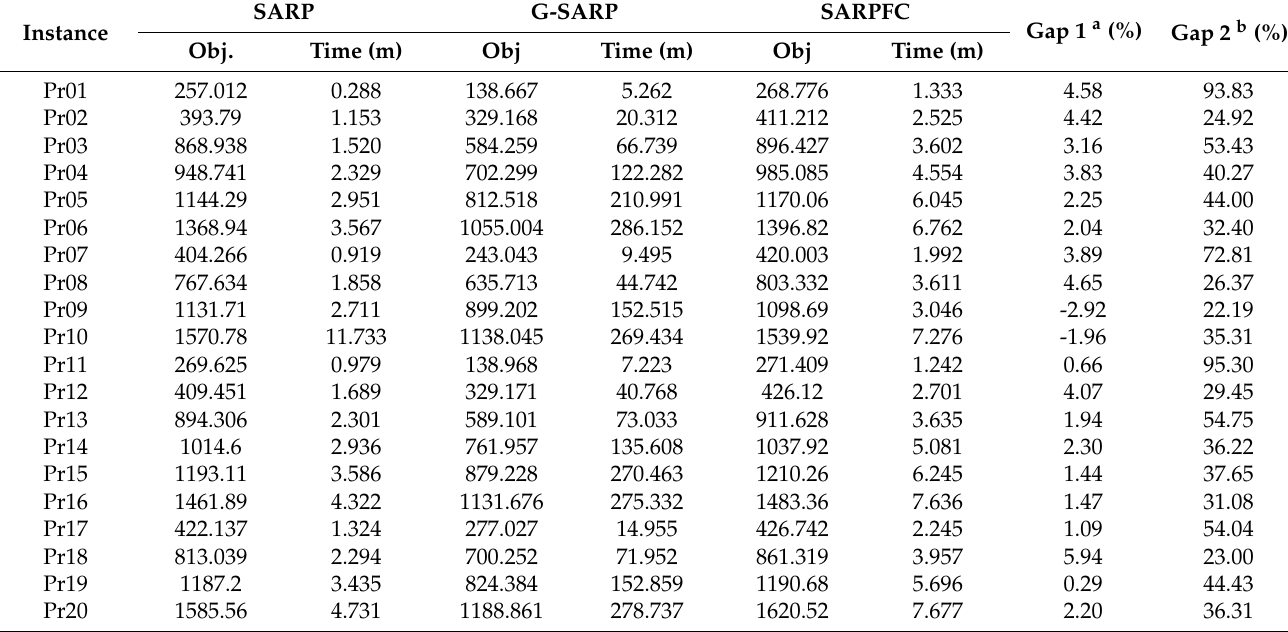
Table 6. Comparison between SARP, G-SARP, and SARPFC solution for large